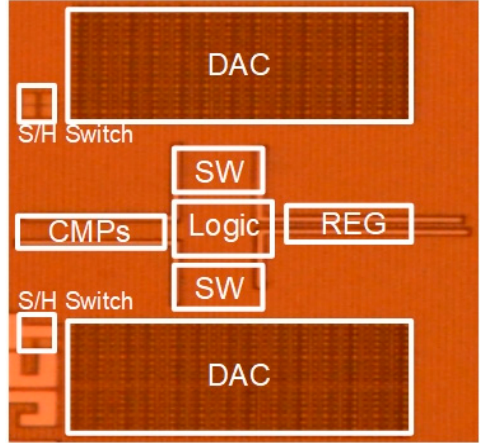
Figure 13. Die microphotograph of proposed SAR ADC.